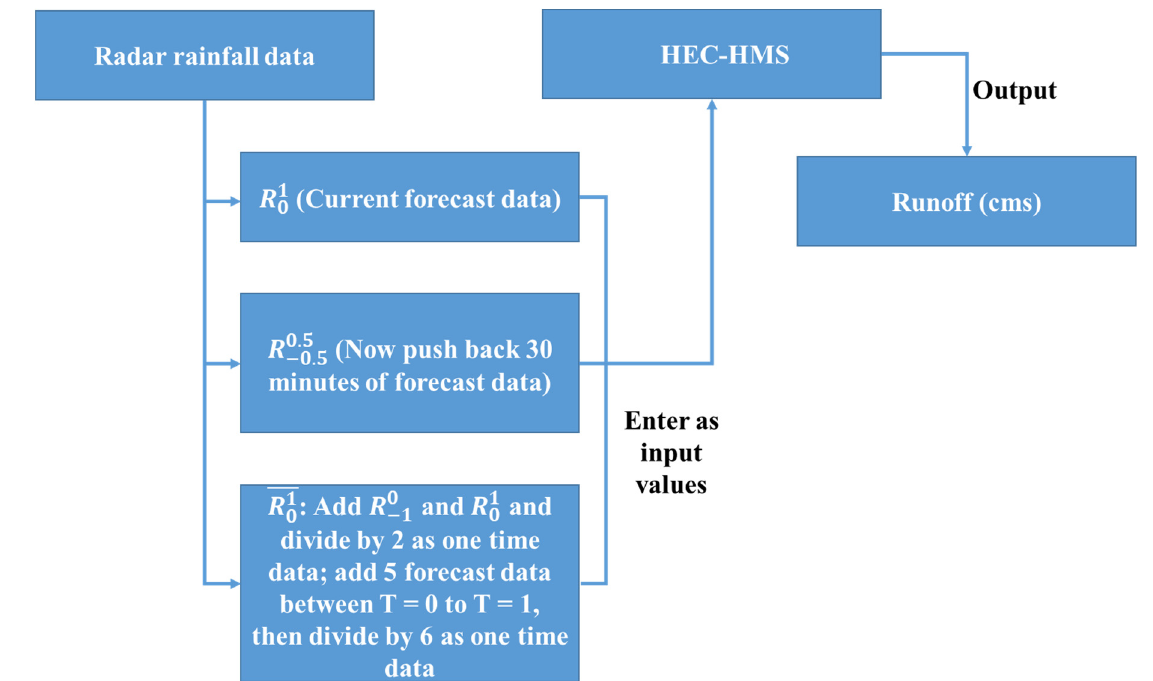
Figure 8. QPF rainfall calculation method.